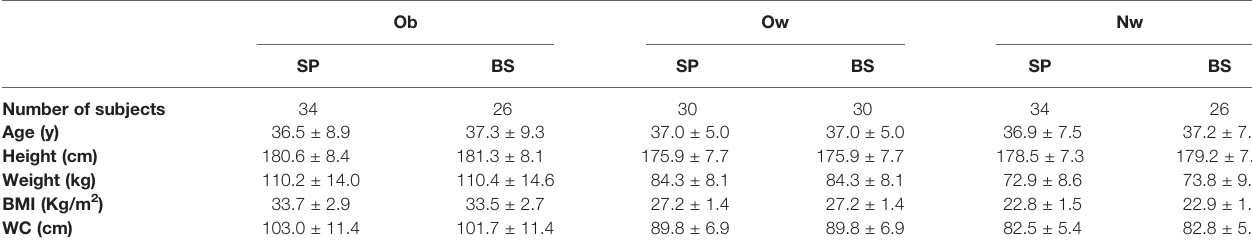
TABLE 1 | Anthropometric characteristics in obese, over weight, and normal weight